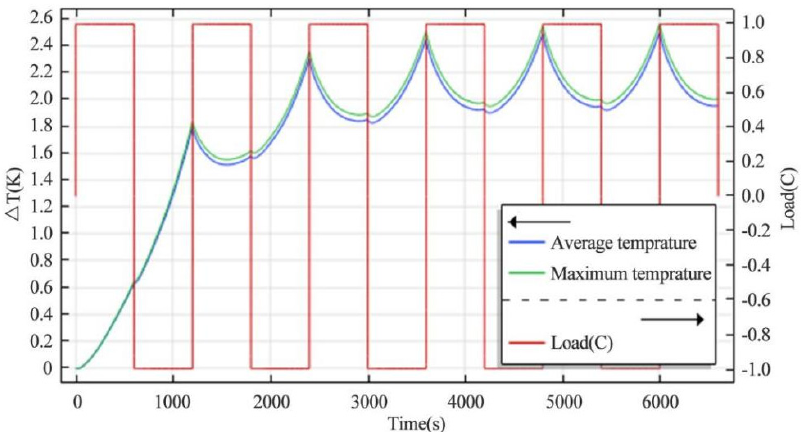
Figure 9. Changes in battery temperature and load under the continuous charge–discharge cycle.